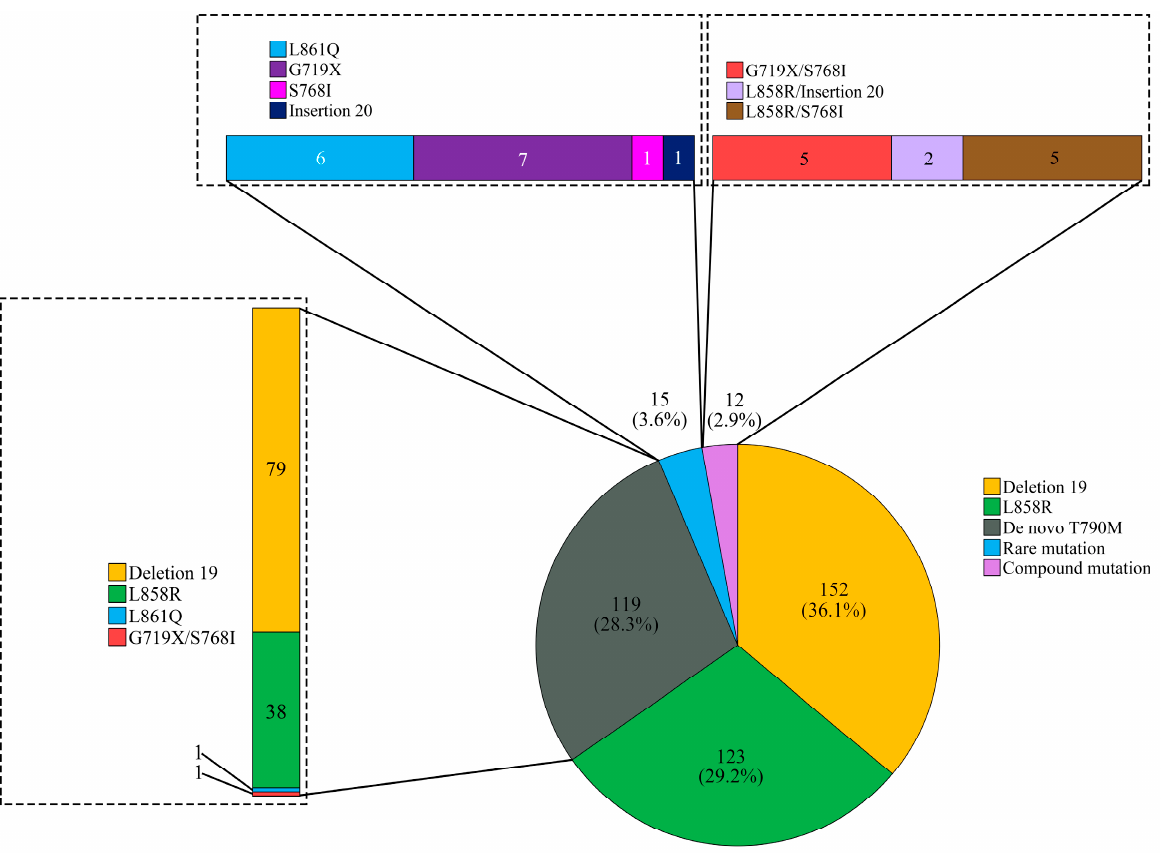
Figure 1. The composition of the EGFR mutations. The most common mutation was deletion 19 (152 cases, 36.1%), followed by L858R (123 cases, 29.4%). A total of 119 cases (28.3%) revealed de novo T790M mutation. Table 2. The composition of EGFR mutation types detected by ctDNA analysis.